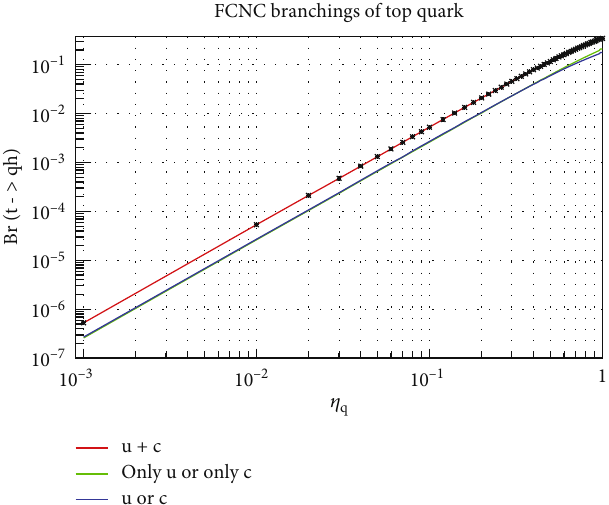
Figure 2: FCNC branchings of top quark for three scenario presented: u + c indicates top quark can decay them both via Higgs. Only u or only c assumes top quark can decay only one of them and the other channel is closed. At last case, top both channels are accessible but only one of them is preferred. To access beyond the FCNC regions excluded by LHC ð Br ð t ⟶ qh Þ ~ O ð 10 − 3 ÞÞ , one needs to set bound for the coupling constant roughly below η = 0 : 04 . q